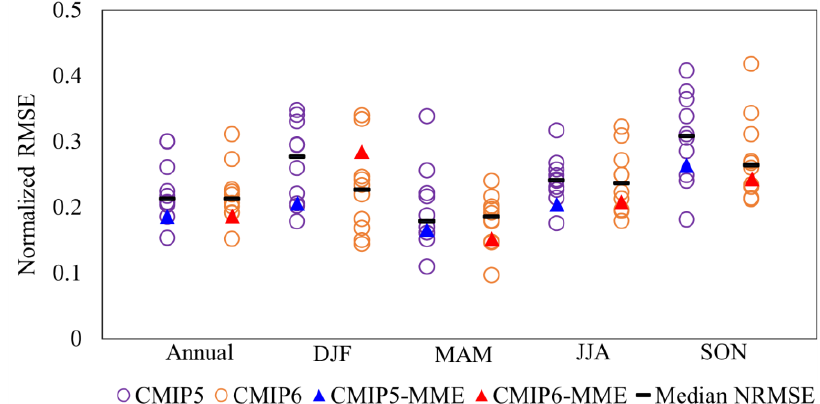
Figure 7. Normalized root-mean square error (NRMSE) in precipitation projection by CMIP5 GCMs (purple empty circles), CMIP6 GCMs (orange empty circles), CMIP5-MME (blue filled triangles) and CMIP6-MME (red filled triangles), as well as median errors (solid line).